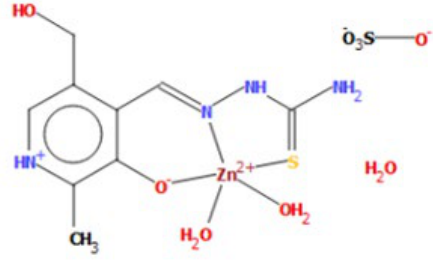
Figure 2. Square-pyramid geometry of Zinc complex (compound 2 ) 14].